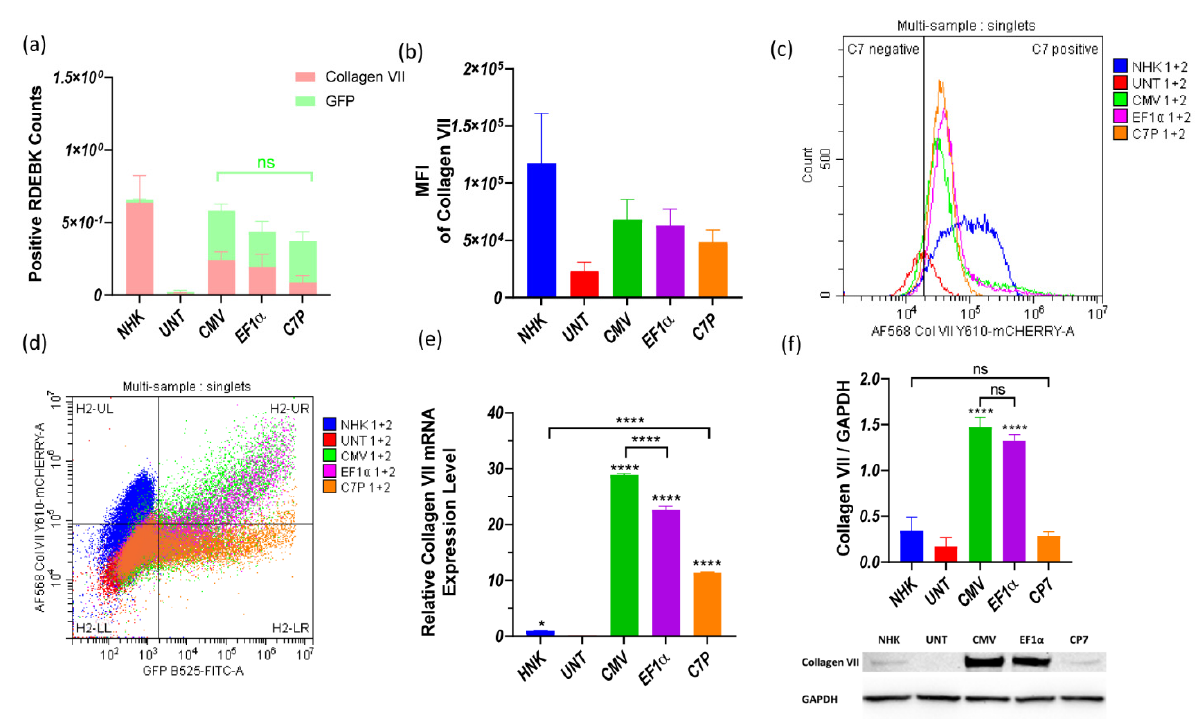
Figure 3. Collagen VII expression from untreated NHK and RDEBK cells transfected with plasmid/BrPERfect complexes. ( a ) NHK and RDEBK cells positive for GFP and C7 expression after transfection with MN511C7-CMV, MN511C7-EF1 α and MN511C7-C7P plasmids. ( b ) Mean fluorescence intensity of C7 of NHK and treated RDEBK cells. ( c ) Distribution of positive NHK cells and RDEBK cells for C7 expression. ( d ) Gate strategy of the flow cytometry results and the dot plot of single cells. ( e ) COL7A1 gene transcription level of RDEBK and NHK cells was compared by RT-qPCR. ( f ) C7 protein monomer (290 KDa) was detected by western blot, and its expression level was semi-quantitated and normalized with the loading control protein GAPDH. UNT: untreated RDEBK cells; CMV: MN511C7-CMV transfected RDEBK cells; EF1 α : MN511C7- EF1 α transfected RDEBK cells; C7P: MN511C7- C7P transfected RDEBK cells; MFI: mean fluorescence intensity. For ( a – d ) data were collected from 3 independent experiments except for controls that data were collected from 2 independent experiments. For ( e ) data were collected from 3 replicates and ( d ) data were collected from 3 replicates of 3 independent experiments and presented as means ± SD ( n = 3). **** p < 0.0001, * p < 0.05, as compared between different columns. ns: not significant.